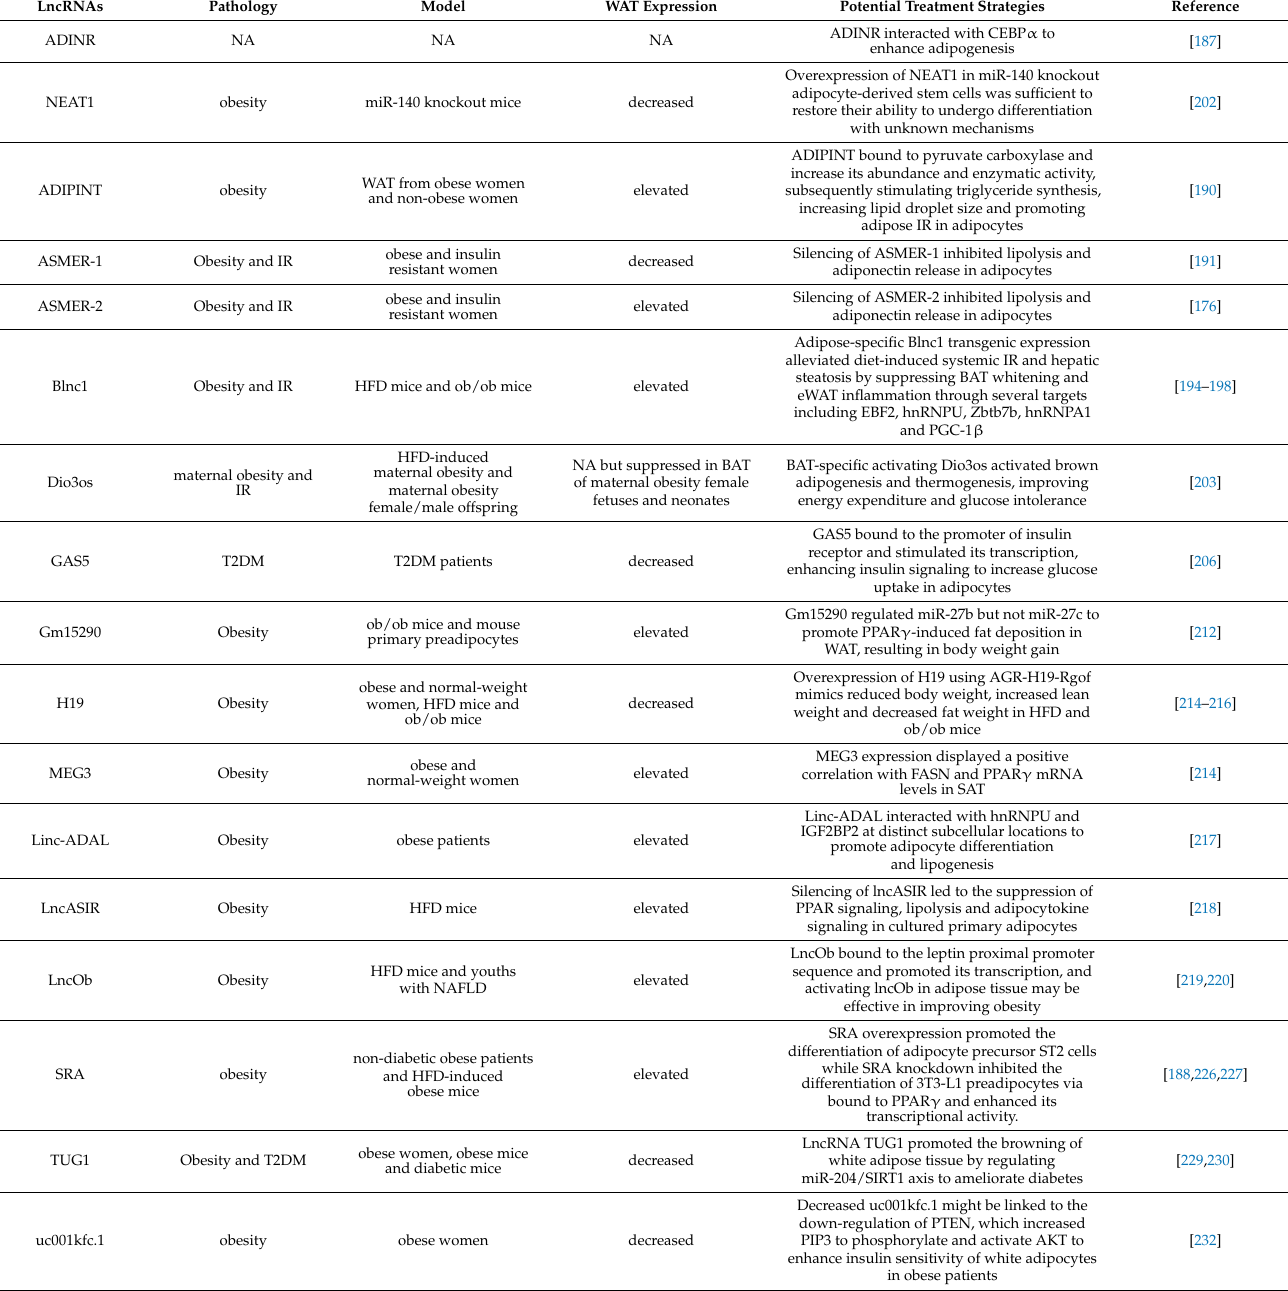
Table 3. LncRNAs in adipocyte IR and related